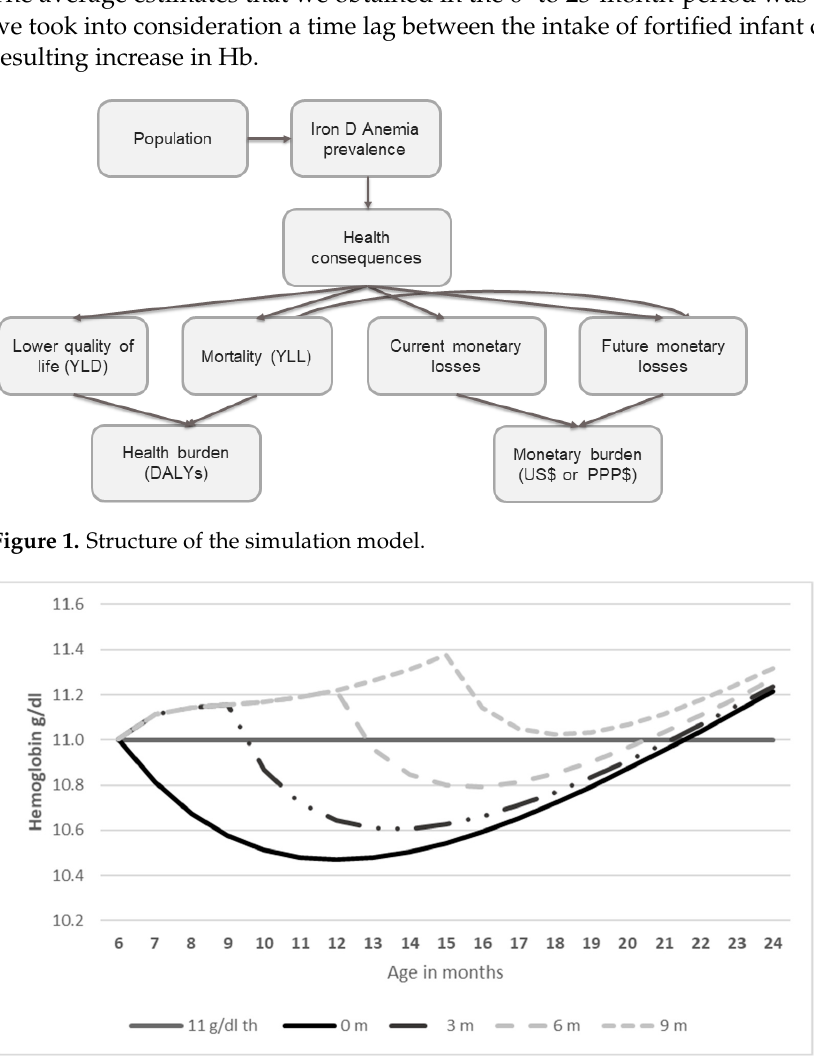
Figure 2. Modeling of the hemoglobin concentration trajectory according to the duration of consumption of fortified infant cereals.